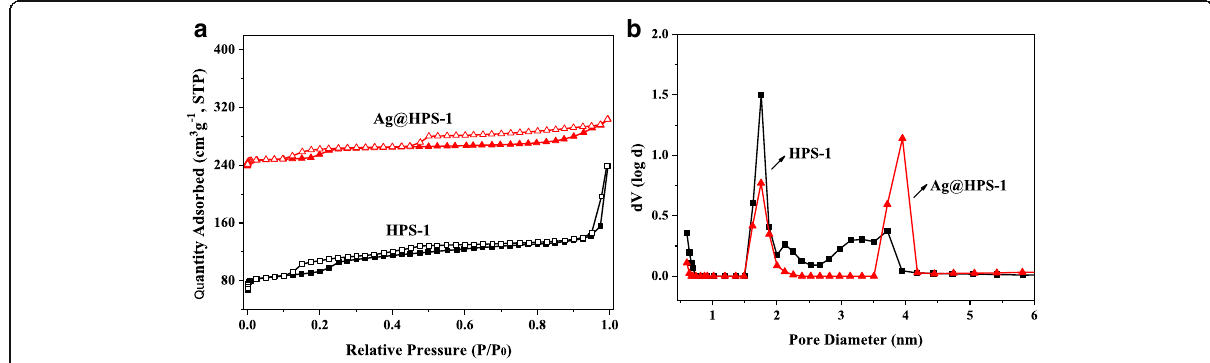
Fig. 4 a The N 2 adsorption-desorption isotherms and b the corresponding pore size distribution curves of HPS-1 and Ag@HPS-1